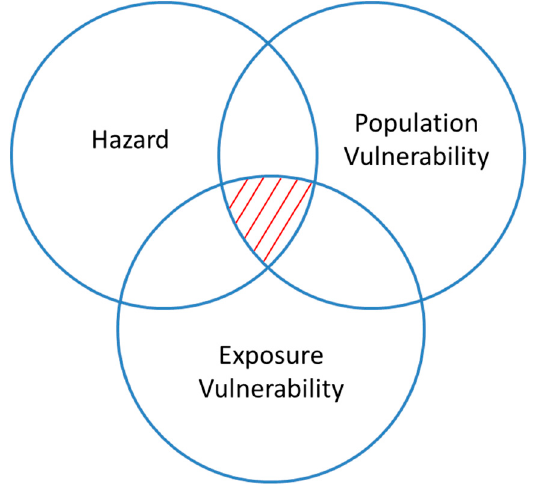
Figure 2. Schematic diagram of risk definition (red area).